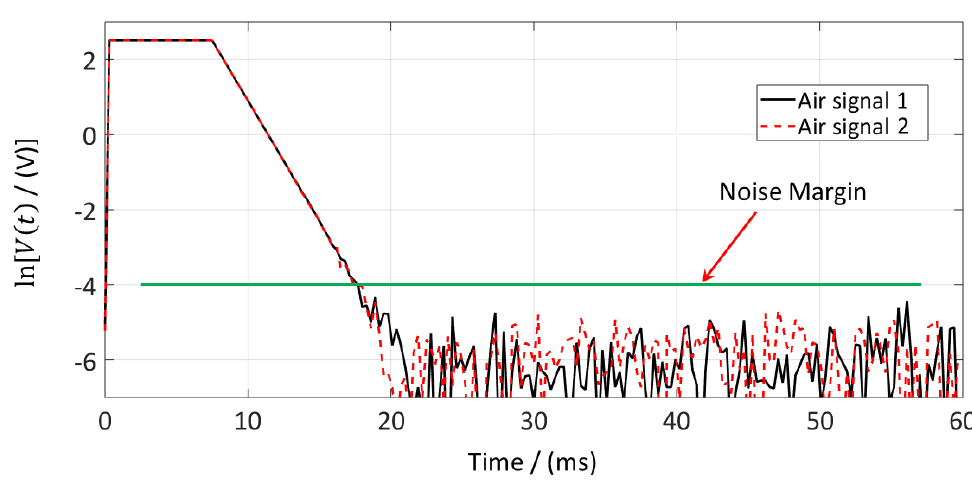
Figure 5. Noise-margin